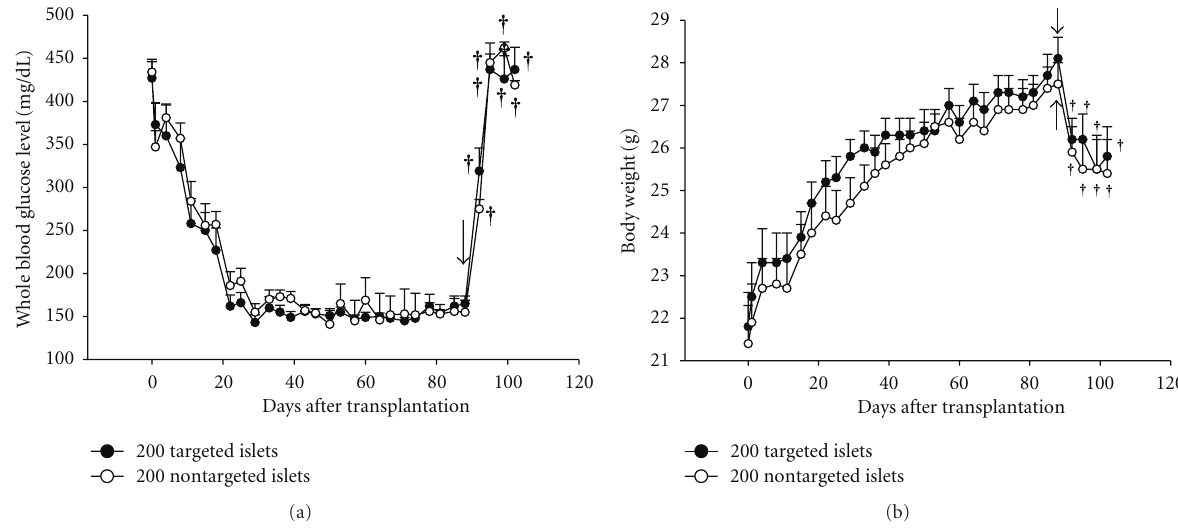
Figure 3: Long-term ex vivo e ff ect of p27 Kip1 silencing on the blood glucose level (a) and body weight (b) in a syngeneic mouse transplantation model. Each mouse with streptozotocin-induced diabetes was transplanted with 200 mouse islets transduced with either shRNAs to p27 kip1 or the non-target shRNA control under the left renal capsule at day 0. After transplantation, blood glucose level and body weight were measured. At 84 days following transplantation, the graft-bearing kidneys of all mice were removed by nephrectomy (solid arrow), and all mice were kept alive for 2 weeks before being sacrificed. In Figures 3(a) and 2(b), ∗ P < 0 . 05, † P < 0 . 01 indicates the marked mean compared to that on day 84 in the same group using paired Student’s t -test.